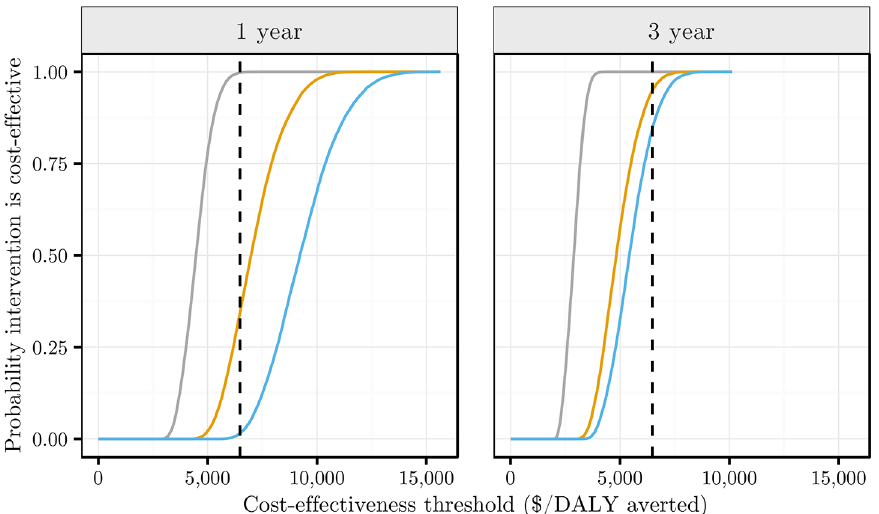
Fig 3. Cost-effectiveness acceptability curves. These curves show the probability that introduction of POC CD4 testing compared to laboratory CD4 testing is cost-effective at a range of decision rule thresholds for the 1 year projection (left) and 3 year projection (right). The colours correspond to (left to right within each plot): grey — current care (CC) context, orange — enhanced counselling and testing (ECT), blue — universal test and treat (UTT). The dashed line shows South African GDP per